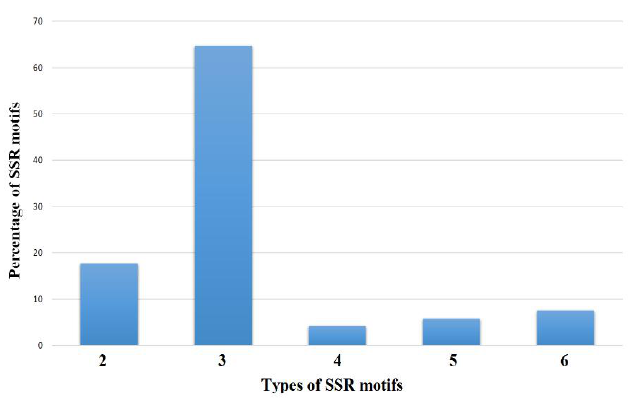
Figure 1. The percentages of SSR motifs Distribution of SSRs in open reading frames and the amino acids for tri- and hexanucleotide Of all identified microsatellites, 53.80% were distributed across the middle region or coding regions, while about 34.87% were located near the 5 ' end, and 11.34 % were located near the 3 ' end. In addition, hexanucleotide (68.42%) and tri-nucleotide (61.25%) SSRs were the most frequent in the coding regions, whereas, tetra and SSRs were the least frequent there. In contrast, pentanucleotide (60.71%) and tetranucleotide (50 %) SSRs were the most frequent in UTRs 5’. Each tri-nucleotide or hexanucleotide motif codes for amino acids that have a potential role in the biological activity of protein molecules. Of the 838 tri- and hexanucleotides identified in the present study, 17.45% encode Arginine, 16.78 % encode Alanine, 11.95 % Proline, and 8.99 % Glycine (Figure 3). Functional characterization of unigenes containing SSR Out of 959 unigenes, 854 have homologous with known proteins. The outcome showed that 6.46 % is exclusive to Triticum aestivum and more than 90 % was conserved between the other species like Zea mays, Aegilops tauschii, Oryza sativa, Brachypodium distachyon, and Hordeum vulgare (Figure 4). The percentages of the conserved regions for Zea mays, Aegilops tauschii, and Oryza sativa were 12.13 %, 7.78 %, and 7.34% respectively. Additionally, these 854 unigenes were submitted to additional annotation using Gene Ontology